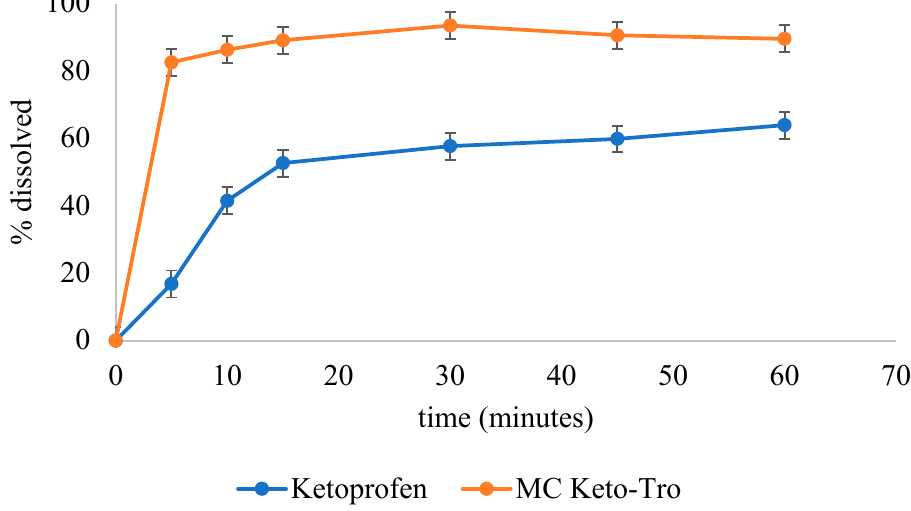
Figure 10. The dissolution profile of intact ketoprofen and multicomponent crystal of ketoprofen and tromethamine in phosphate buffer (pH 7.4).